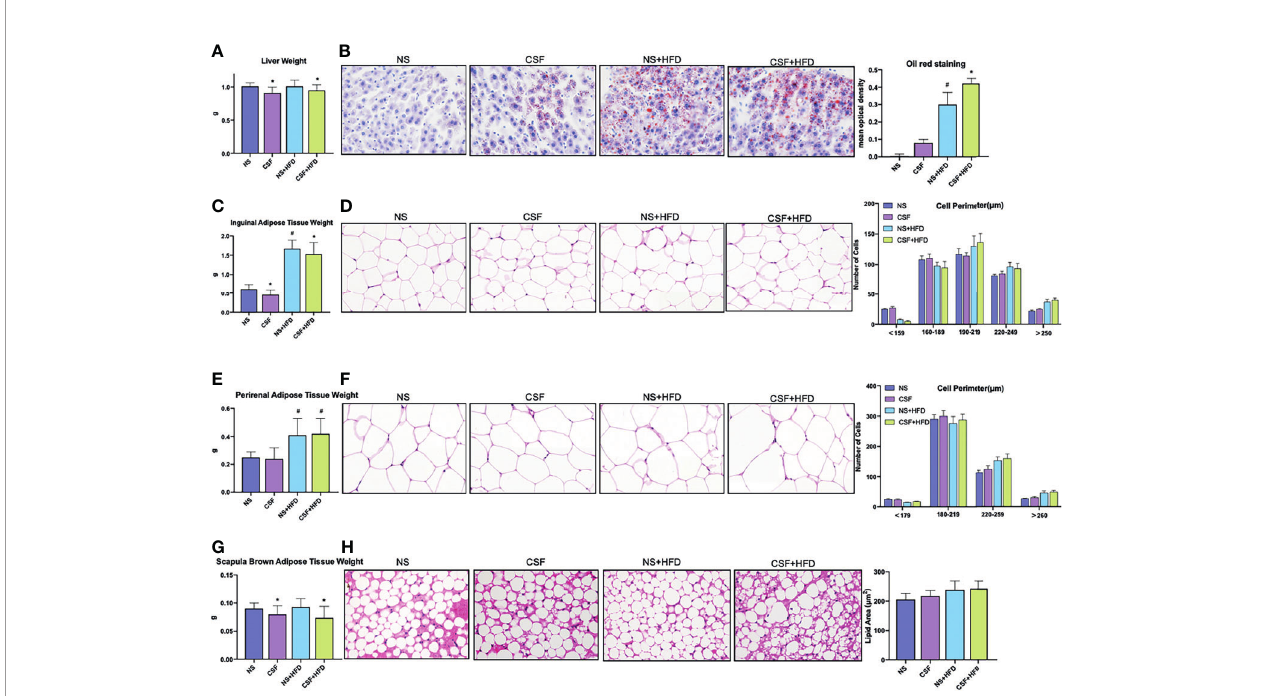
FIGURE 3 | Pro fi les of liver tissue, abdominal subcutaneous and visceral white adipose tissue, and scapula brown adipose tissue of mice exposed to CSF intervention. (A) Liver weights of the mice in the chow diet and HFD groups pre- and post- CSF. (B) Oil red staining of liver tissue and mean optical density of the mice in the chow diet and HFD groups pre- and post- CSF. (C) Inguinal adipose tissue (Abdominal subcutaneous white adipose tissue) weights of the mice in the normal and HFD groups before and after CSF. (D) Hematoxylin-eosin staining and the distribution of adipocyte perimeters of inguinal adipose tissue of the chow diet-fed and HFD-fed mice before and after CSF. (E) Perirenal adipose tissue (abdominal visceral white adipose tissue) weights of the mice in the chow diet and HFD groups pre- and post- CSF. (F) Hematoxylin-eosin staining and the distribution of adipocyte perimeters of perirenal adipose tissue of the mice and brown fat weight of the chow diet-fed and HFD-fed mice before and after CSF. (G) Scapula brown adipose tissue weights of the mice in the chow diet and HFD groups pre- and post- CSF. (H) Hematoxylin-eosin staining and lipid area of scapula brown adipose tissue of the mice in the chow diet and HFD groups pre- and post- CSF. Data are expressed as mean ± SEM. Group differences were assessed by using the Mann ‐ Whitney U test. *P < 0.05 when comparing NS and CSF groups (NS group vs CSF group, NS+HFD group vs CSF+HFD group). # P < 0.05 when comparing chow diet and HFD groups (NS group vs NS+HFD group). Original magni fi cation: 400